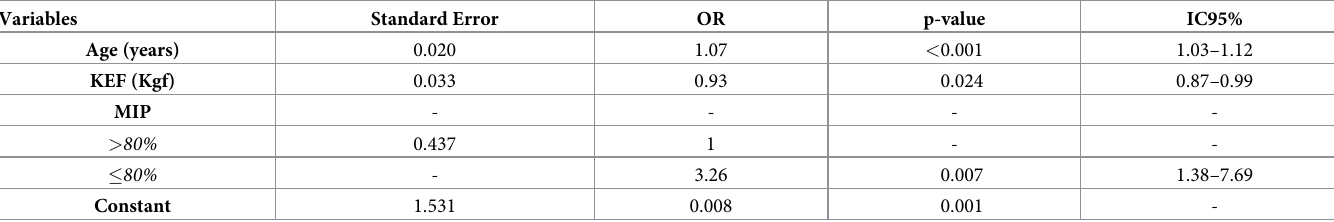
Table 3. Binary logistic regression for variables associated with postural